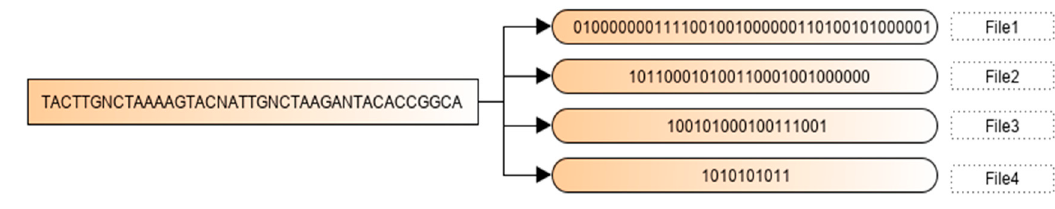
Figure 4. The encoding process of the binary encoding scheme.